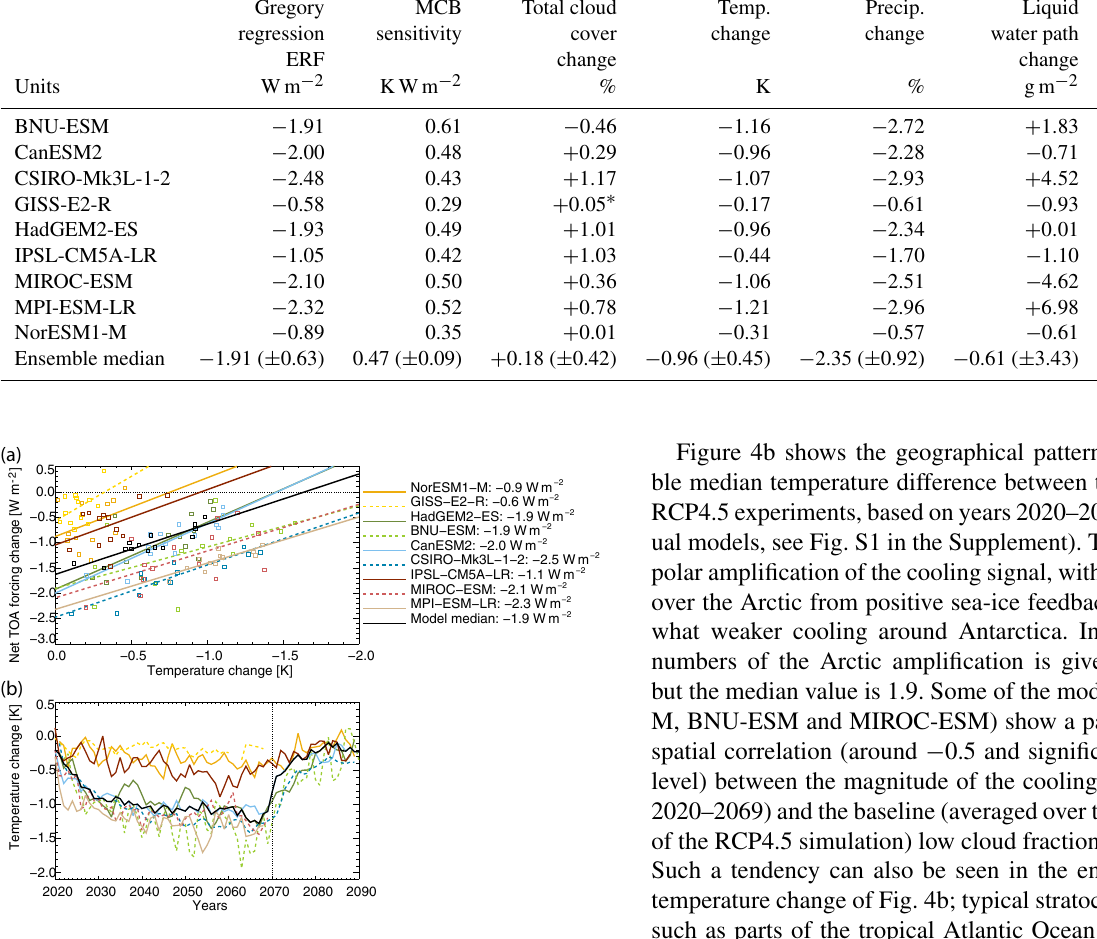
Figure 3. (a) Regression of global annual means of the net TOA radiative flux imbalance and near-surface temperatures for each model (see Gregory et al., 2004). Each square represents global annual mean for each of the first 10 years and decadal means for the remaining part of the simulations (i.e. last four decades, 2030– 2069). Numbers to the right gives the intercept – i.e., the effective radiative forcing. (b) Time series of the difference in global annual mean near-surface temperature between G4cdnc and RCP4.5 for each model. Dotted vertical line indicates the onset of the termi- nation